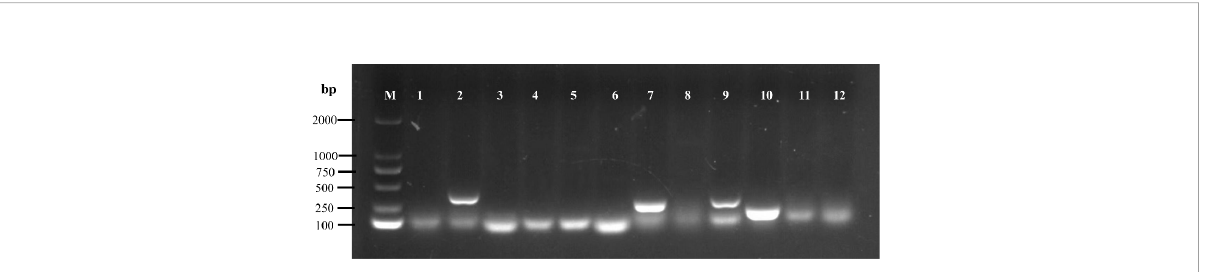
FIGURE 5 Agarose gel electrophoresis of the PCR products of virulence genes. M: DL2000 marker. Lane 1: nqr F, 2: lon R, 3: atp A, 4: gua A, 5: lux , 6: crp , 7: dks A, 8: exu , 9: hem , 10: fur , 11: omp R, 12: fl a